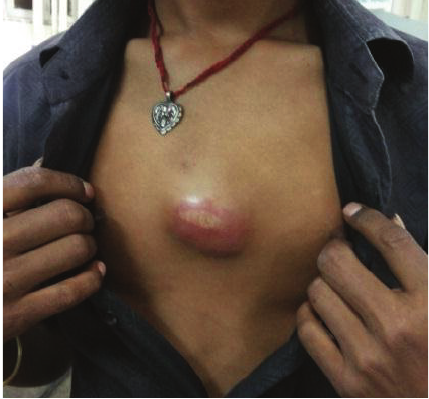
Figure 1: Showing large solitary well defined lesion over sternum.